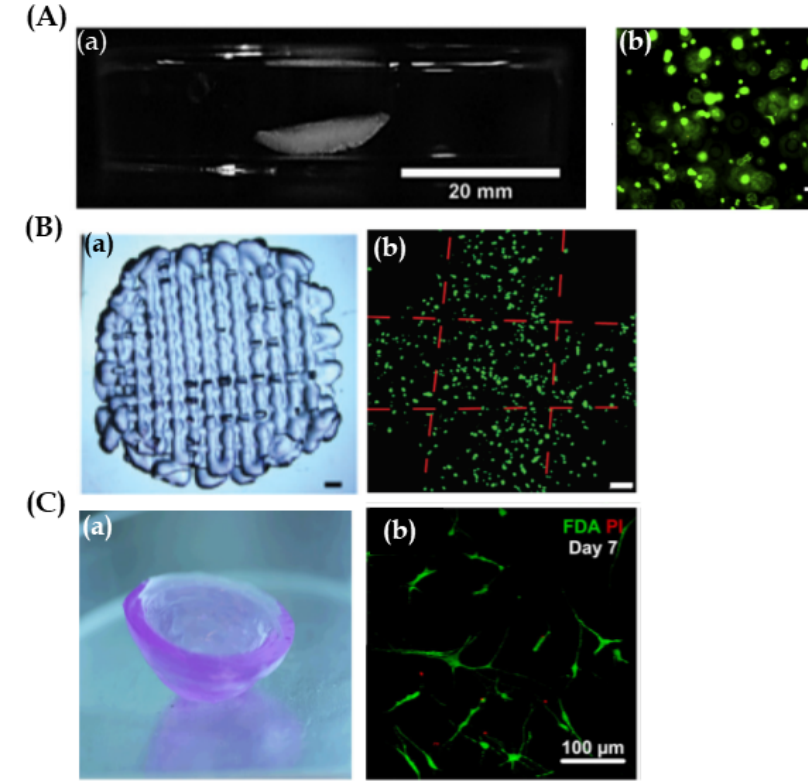
Figure 4. Corneal stroma structures and keratocytes. ( A ) Reproduced with permission form [42], Elsevier, 2018. ( a ) Images of extrusion bio-printed corneal stroma. Scale bar 20 mm. ( b ) Representative live/dead stain images using fluorescence microscopy after 3D bioprinting, showing live (green) and dead (red) cells. Scale bar 250 µ m. ( B ) Reproduced with permission from [44], IOP Science, 2019. ( a ) Stereomicrographs of the methacrylate gelatin scaffold. Scale bar 1 mm. ( b ) Live/dead cell viability assay of 3D printed GelMA scaffolds on day 21, showing live (green) and dead (red) cells. Scale bar 100 µ m. ( C ) Reproduced with permission from [37], Wiley, 2019. ( a ) Macrograph of ink-jet bio-printed 3D type I collagen/agarose scaffold. ( b ) Human corneal stroma keratocytes (CSK) stained with live/dead staining 7 days after bioprinting, showing live (green) and dead (red) cells. It is noticeable that the CSK is spreading and shows typical dendritic shapes in the scaffold. Scale bar 100 µm.